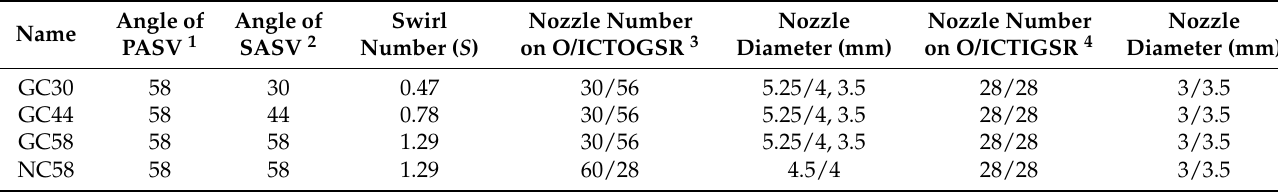
Table 5. Parameters for GC and NC.